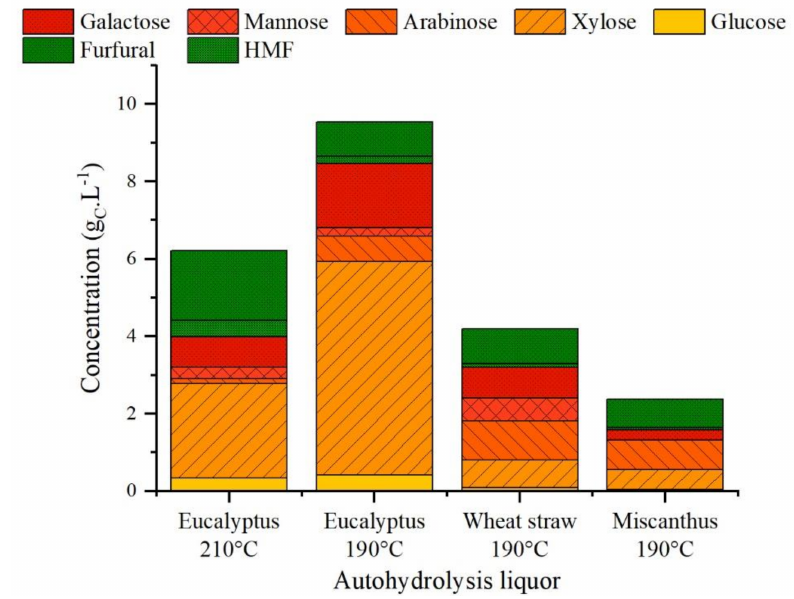
Figure 7. Monomer composition after catalytic hydrolysis at 180 ◦